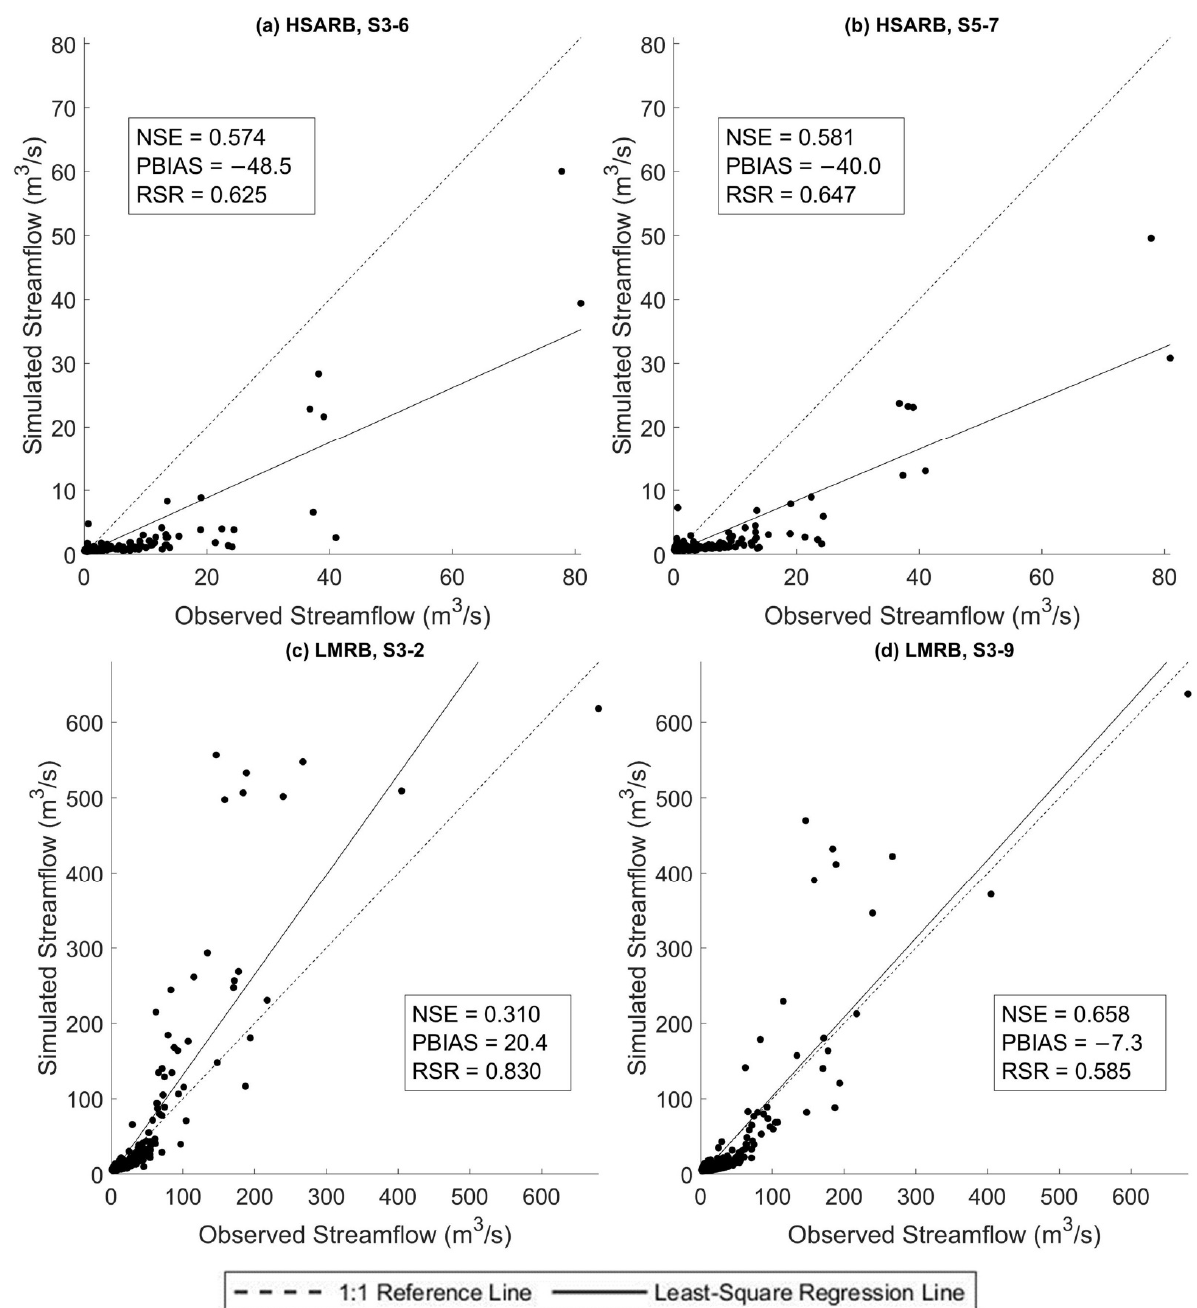
Figure 6. Scatter plots of testing phase daily streamflow of ( a ) HSARB, S3-6; ( b ) HSARB, S5-7; ( c ) LMRB S3-2; ( d ) LMRB S3-9.